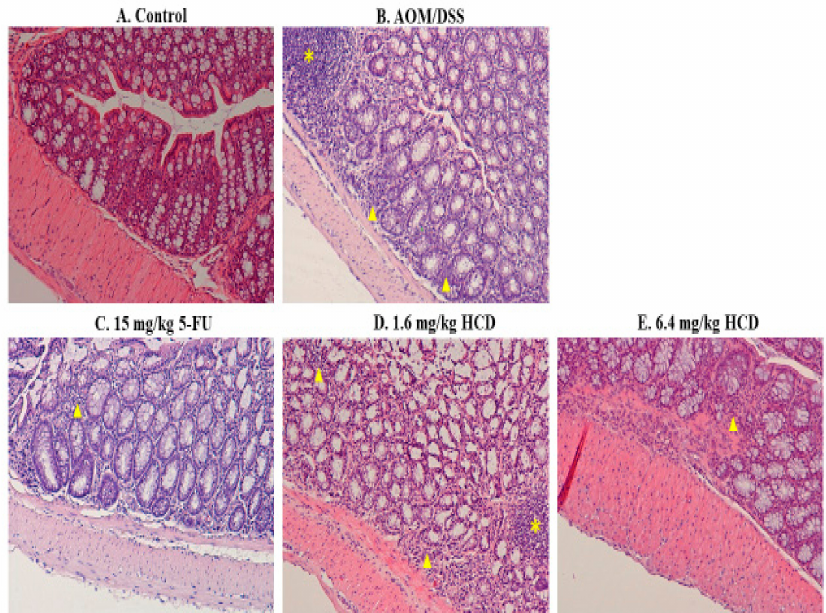
Figure 1. Histological appearances of the longitudinal section in the intestine of mice. Mice treated with ( A ) control and ( B ) azoxymethane (AOM) / dextran sodium sulfate (DSS) induction, as well as AOM / DSS induction followed by ( C ) 15 mg / kg B.wt of 5-fluorouracil (5-FU), ( D ) 1.6 mg / kg B.wt, and ( E ) 6.4 mg / kg B.wt of 16-hydroxycleroda-3,13-dien-15,16-olide (HCD) treatment ( n = 5 in each group), were sacrificed, and the longitudinal section of tissues was stained with hematoxylin and eosin. The yellow asterisk and triangles indicate lymph node and lymphocyte infiltration, respectively, in the intestine. Magnification = × 100.